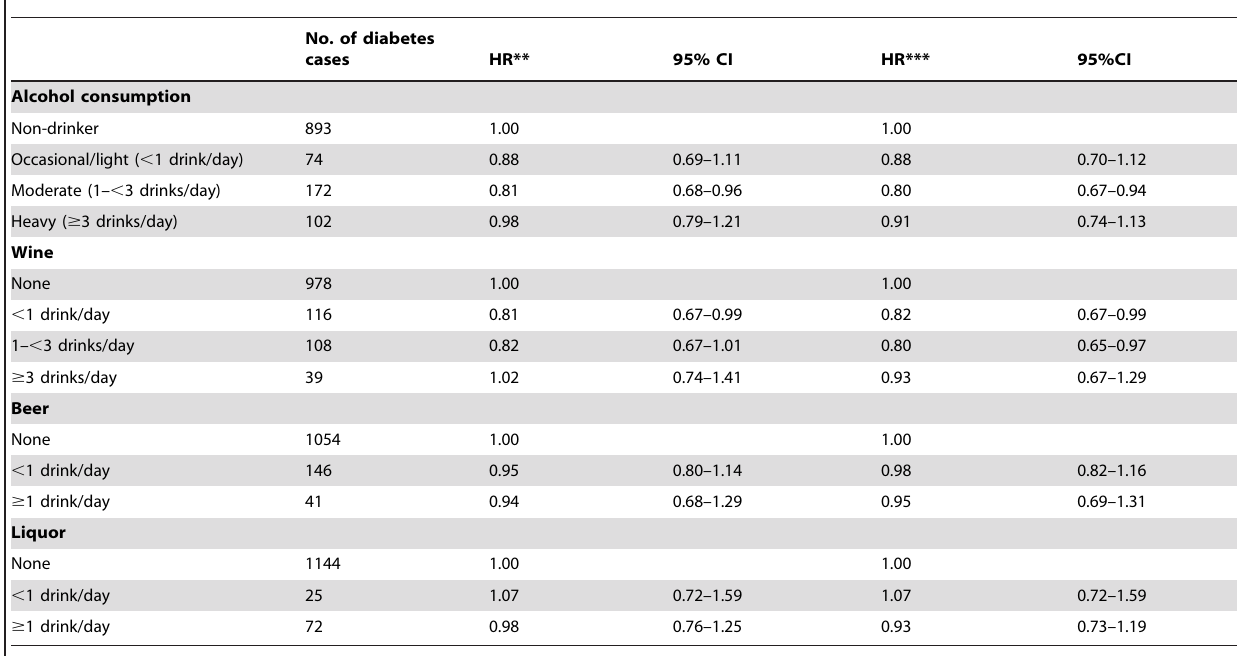
Table 4. Associations between alcohol consumption and T2DM